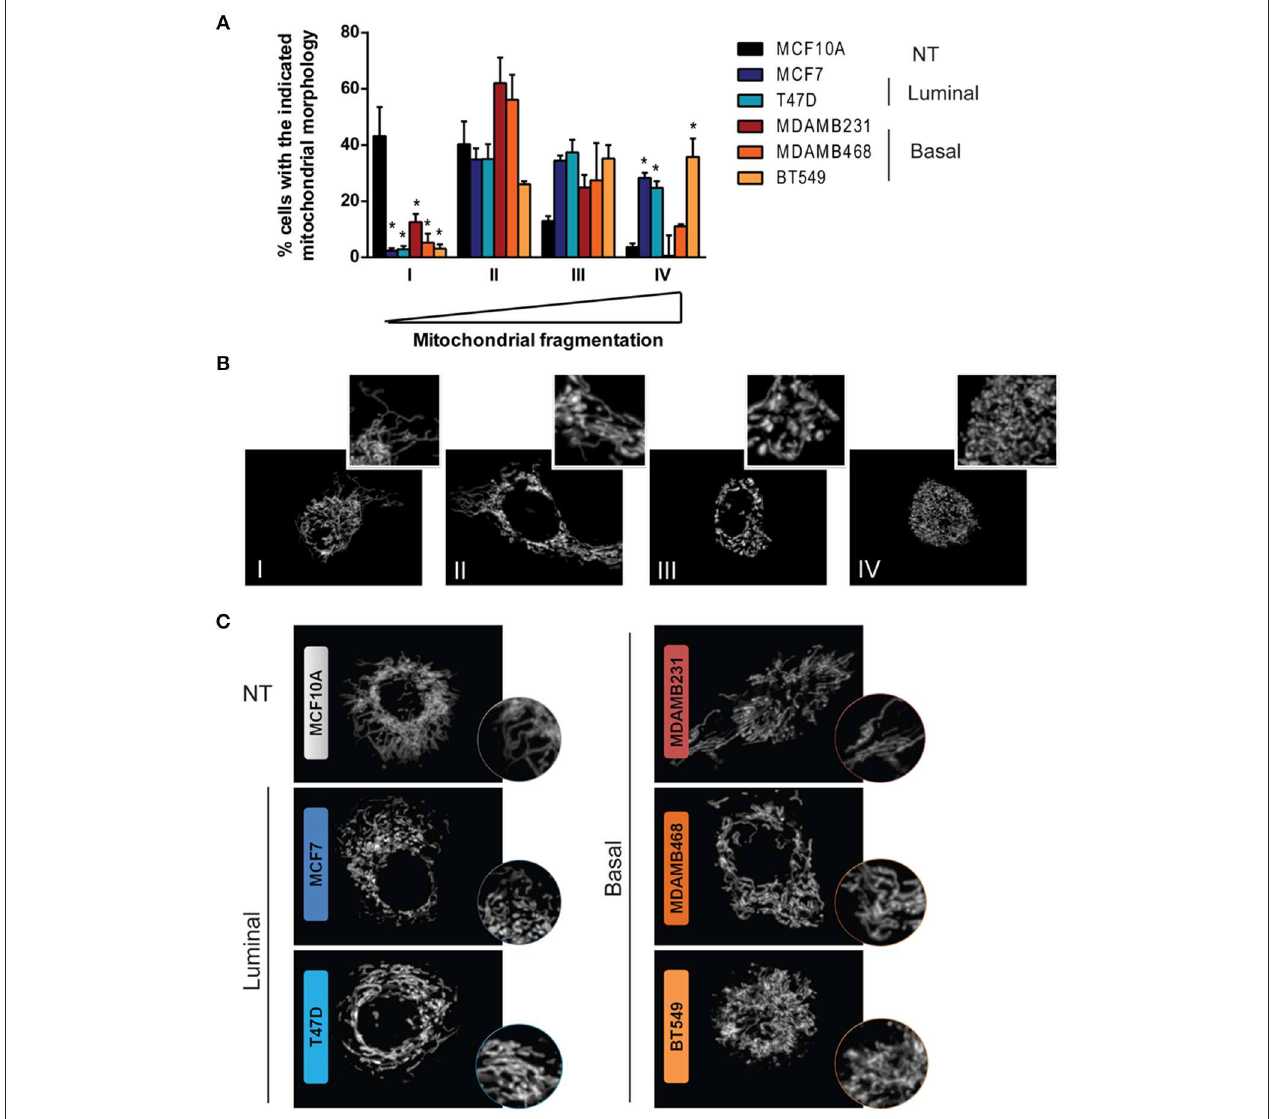
FIGURE 2 | Breast cancer cell lines show differences in mitochondrial morphology and increased mitochondrial fragmentation than a non-tumorigenic cell line. (A) Mitotracker staining revealed differences in mitochondrial morphology among breast cancer cell lines. (B) Cells were classified as completely tubular (I), tubular with some fragments (II), fragmented with some tubules (III), or completely fragmented (IV). The graph in (A) shows the percentage of cells with the corresponding mitochondrial morphology as shown in (B) . In (C) representative images of the characteristic morphology per cell line is shown. The graph in (A) shows mean ± SEM of 3–5 independent experiments. Sixty to one hundred individual cells were classified per experiment by two independent observers. *Different to MCF10A with p < 0.05.